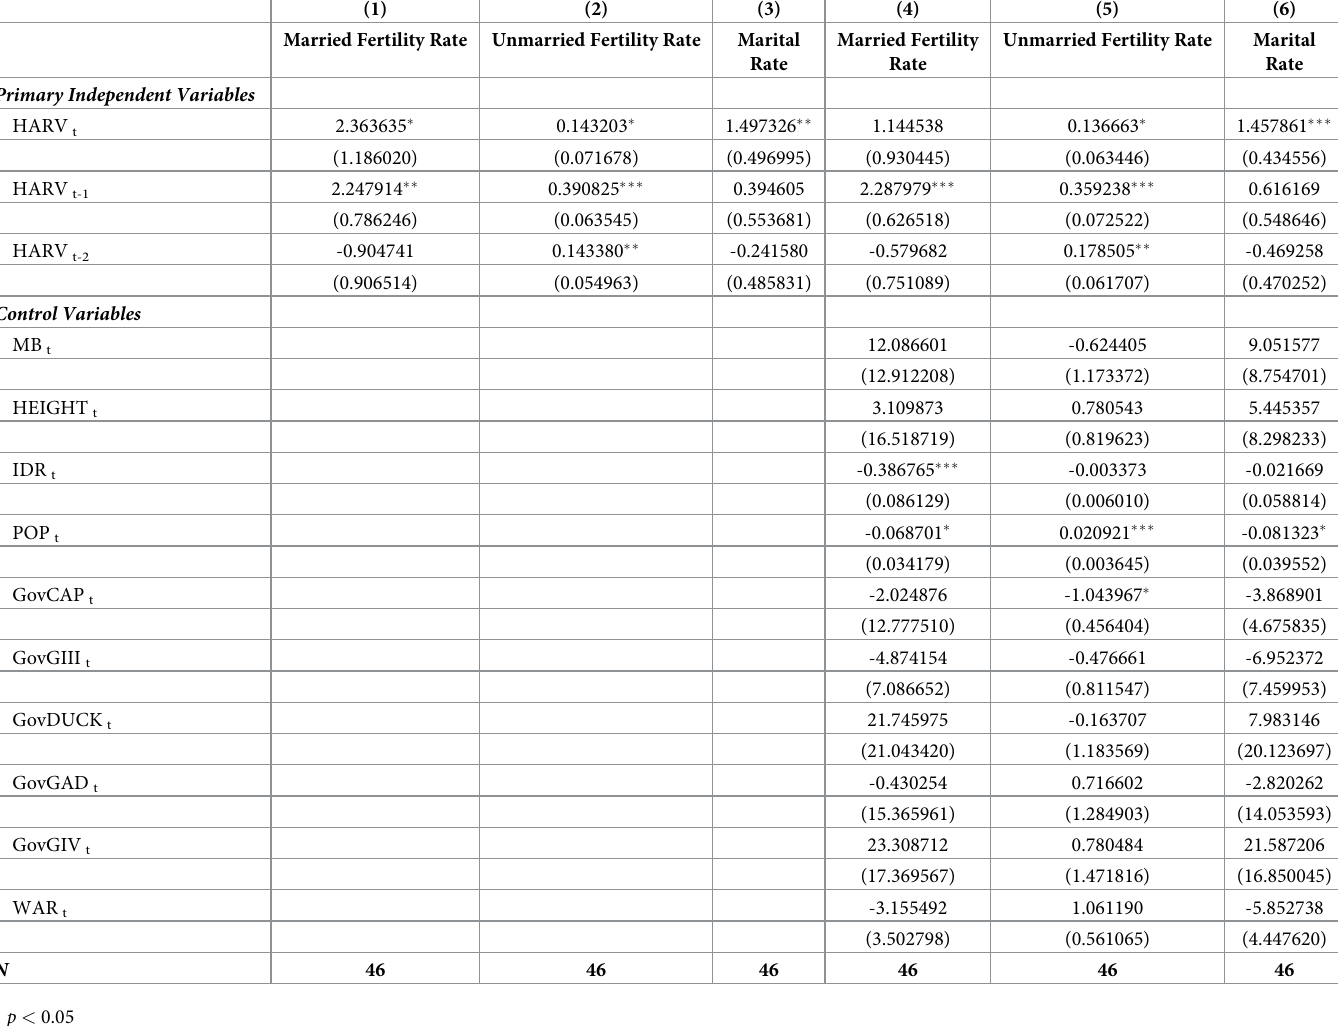
Table 3. The quality of the annual harvest impacted whether people married and had children in 18 th century Sweden. Married Fertility Rate Unmarried Fertility Rate Marital